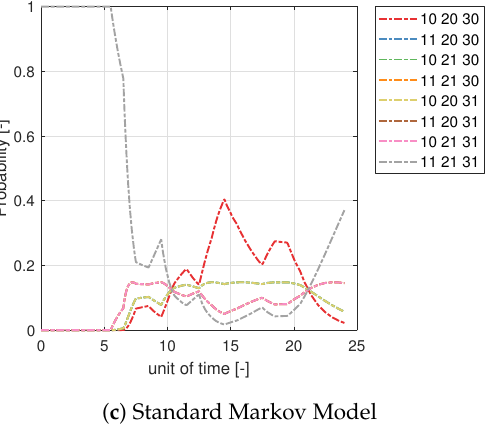
Figure 5. Network State Probability: Three critical lines with wind speed profile ‘A’.